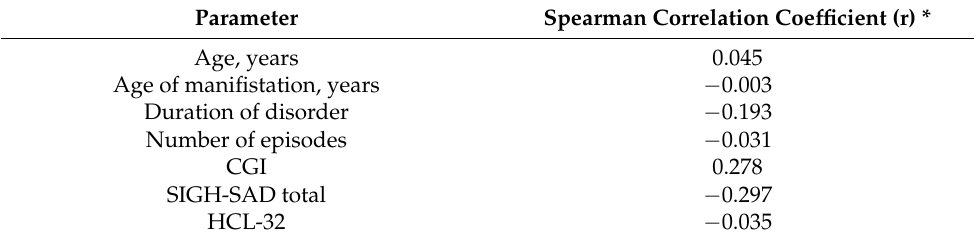
Table A1. Correlation analysis of MBP-hydrolyzing activity of IgGs of bipolar disorder patients with clinical